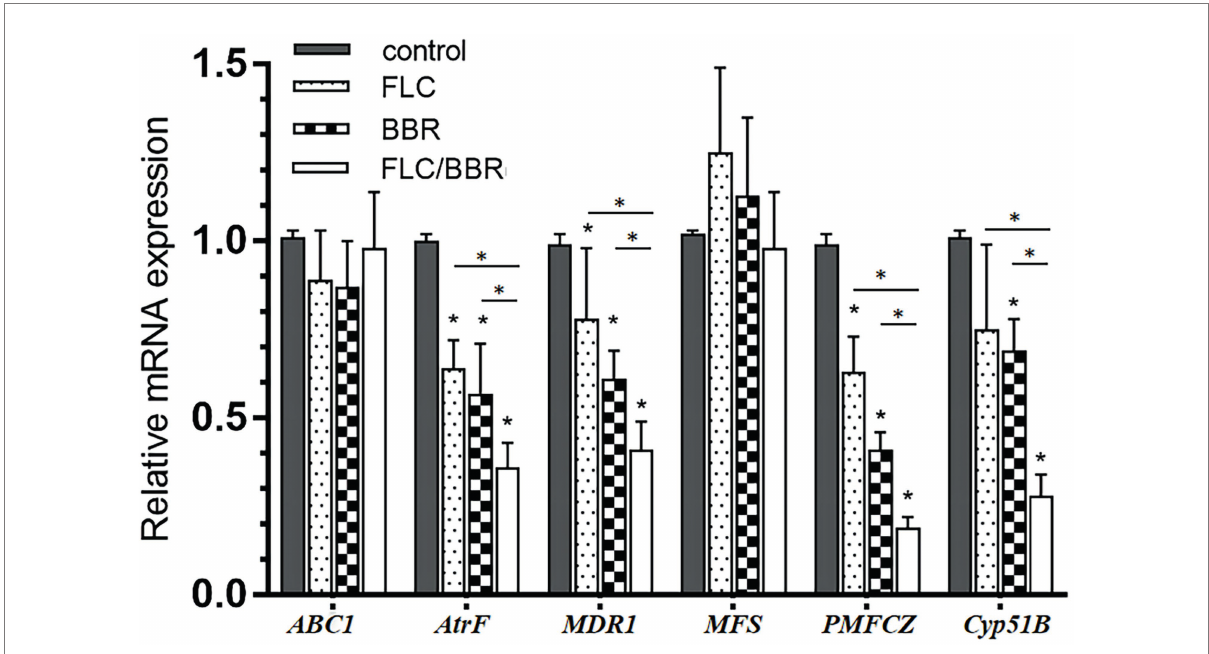
FIGURE 6 Gene expressions of ABC1,AtrF, Mdr1,MFS, PMFCZ and Cyp51B in WT under treatments. * p < 0.05 compared with the control.